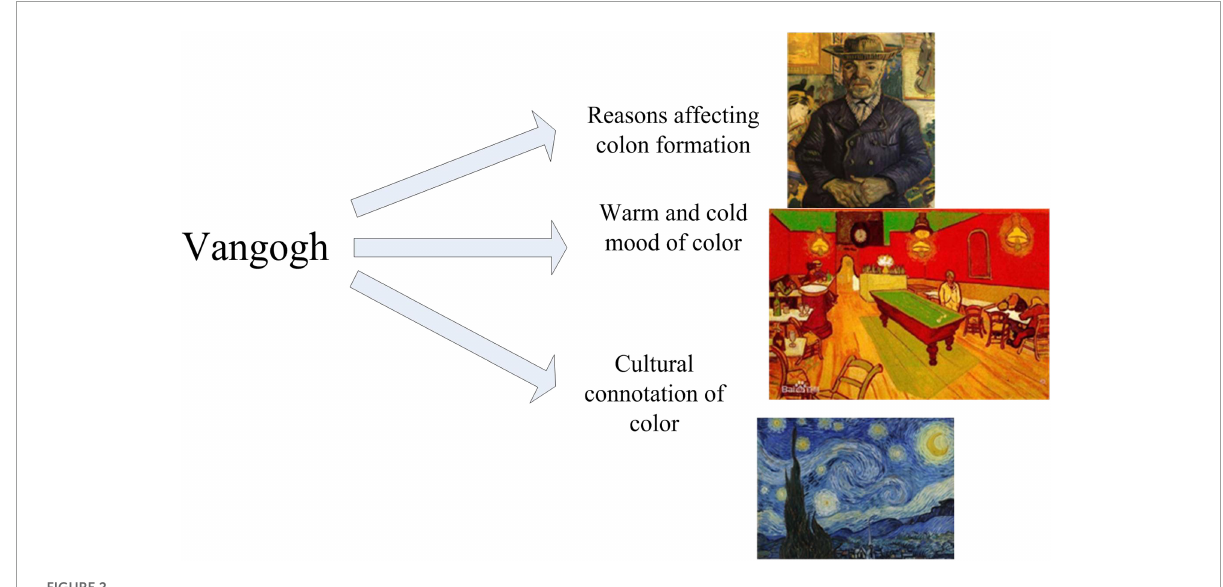
FIGURE2 Colors in Van Gogh’s paintings.